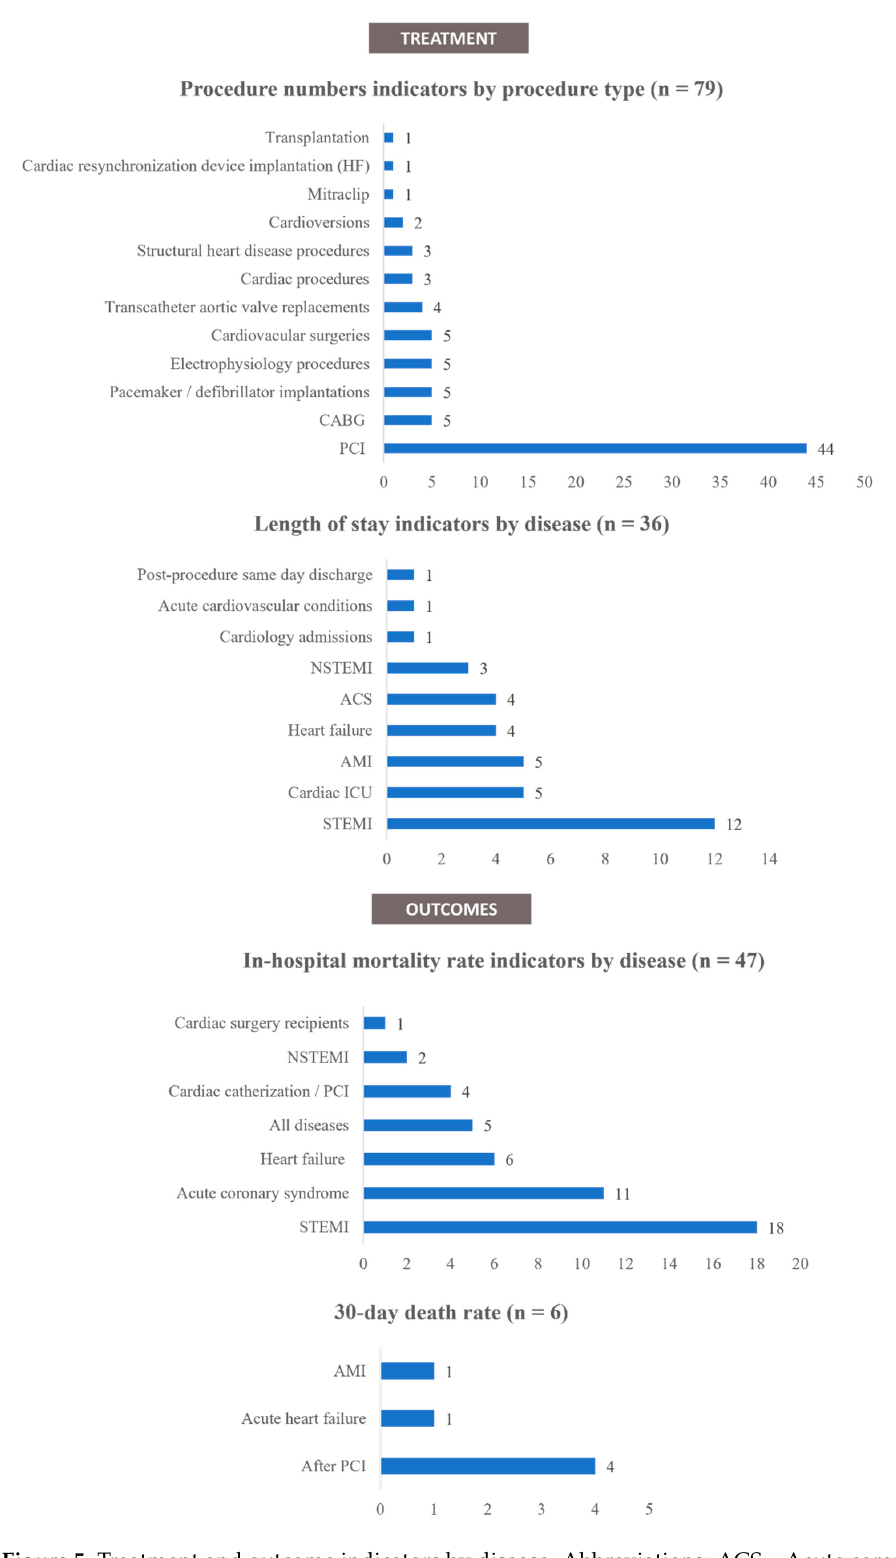
Figure 5. Treatment and outcome indicators by disease. Abbreviations: ACS—Acute coronary syn- dromes; AMI—Acute myocardial infarction; CABG—coronary artery bypass graft; HF—Heart failure; ICU—Intensive care unit; NSTEMI—Non-ST-elevation myocardial infarctions; PCI—Percutaneous coronary intervention; STEMI—ST-elevated myocardial infarctions; SPECT-MPI—Single-photon emission computed tomography myocardial perfusion